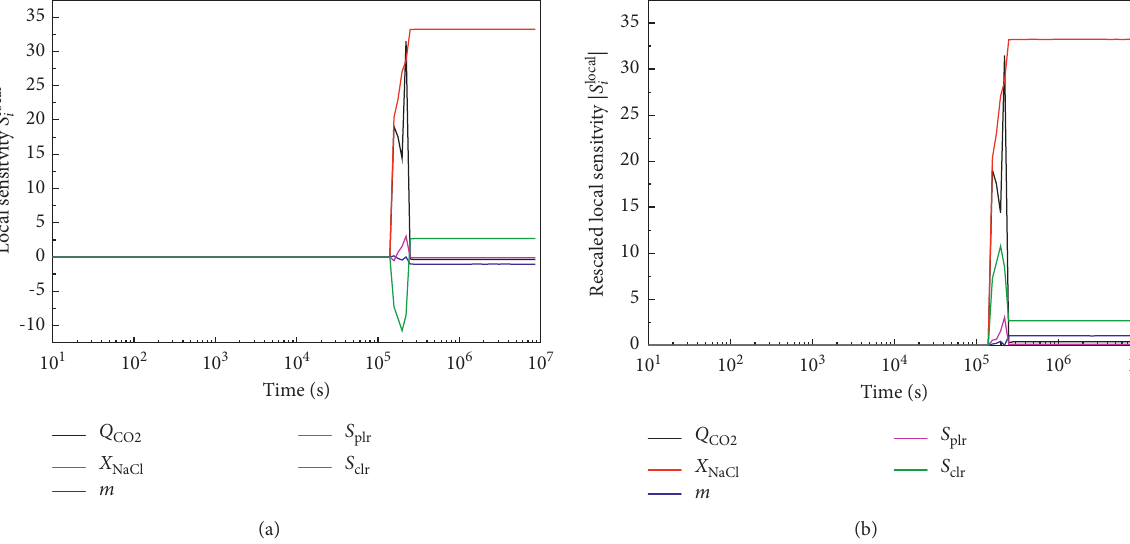
Figure 7: Time evolution of local sensitivity coefficient: (a) local sensitivity coefficient; (b) absolute values of the local sensitivity